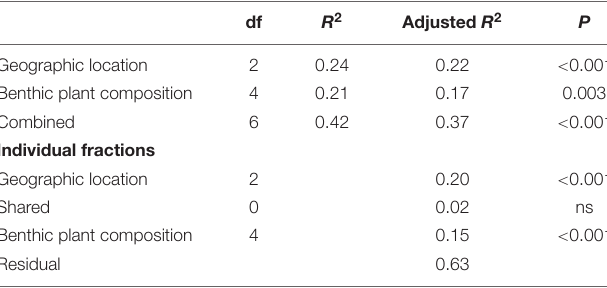
interactions with bottom-up influences would be a valuable future